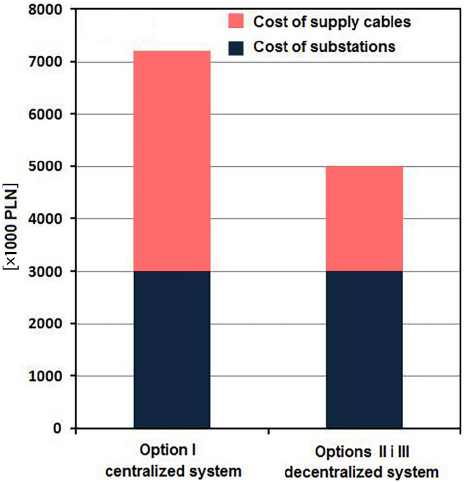
Fig. 11. Comparison of investments costs of supply options